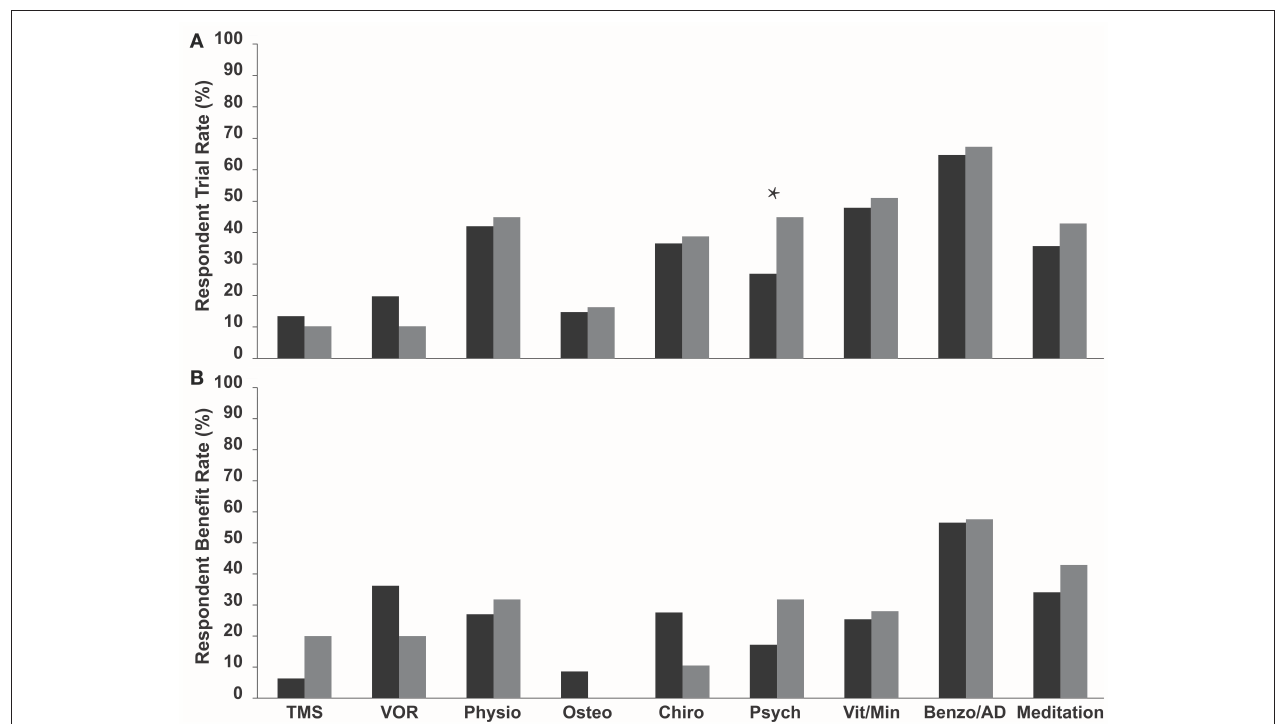
FIGURE 1 | (A) Trial rate and (B) Reported benefit rate (a reduction or relief of symptoms following treatment) of various current treatments and symptom management strategies amongst MT (dark grey bars) and SO (light grey bars) MdDS respondents. Benzodiazepines/Antidepressants were the most commonly trialled in both groups, and SO respondents on average trialled more treatments and symptom management strategies compared to MT respondents. Benzodiazepines/Antidepressants had the highest benefit rate in both groups. Benefit rates between the two groups did not vary significantly. * p < 0.05. TMS, Transcranial Magnetic Stimulation; VOR, Vestibular Ocular Reflex; Physio, Physiotherapy; Osteo, Osteotherapy; Chiro, Chiropractics; Psych, Psychology; Vita/Min, Vitamins/Minerals; Benzo/AD,